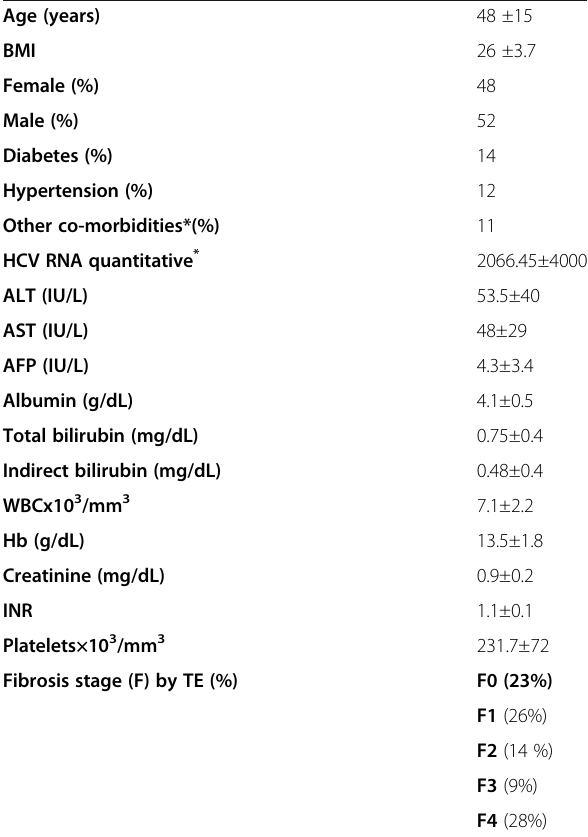
Table 2 Baseline patients ’